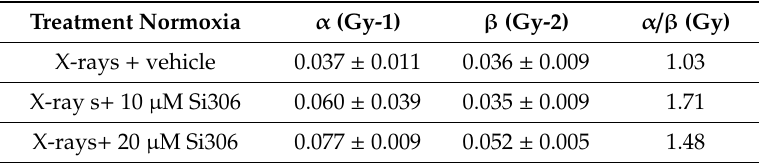
Table 2. α and β parameters by fitting the cell survival to the linear-quadratic (LQ) model in normoxia. Values correspond to mean ± SEM; three independent experiments.